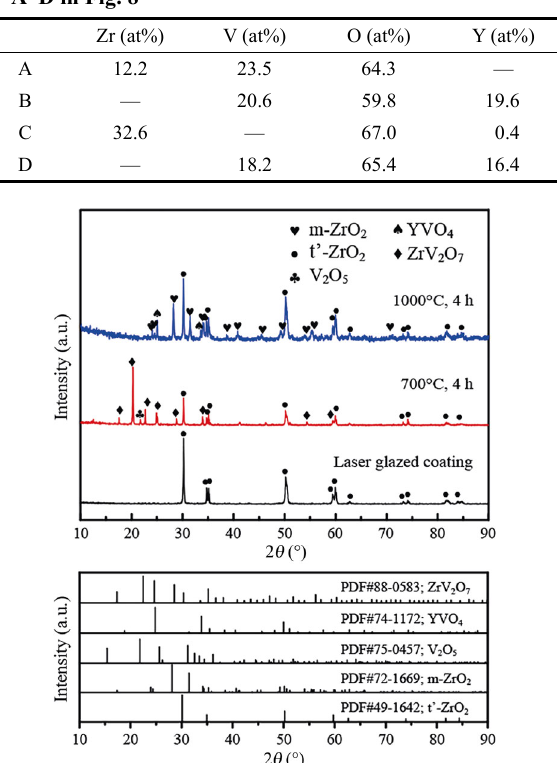
Fig. 9 XRD patterns of the laser glazed YSZ coatings after hot corrosion tests. The standard PDF cards of ZrV 2 O 7 , YVO 4 , V 2 O 5 , m-ZrO 2 , and t’-ZrO 2 are also presented.